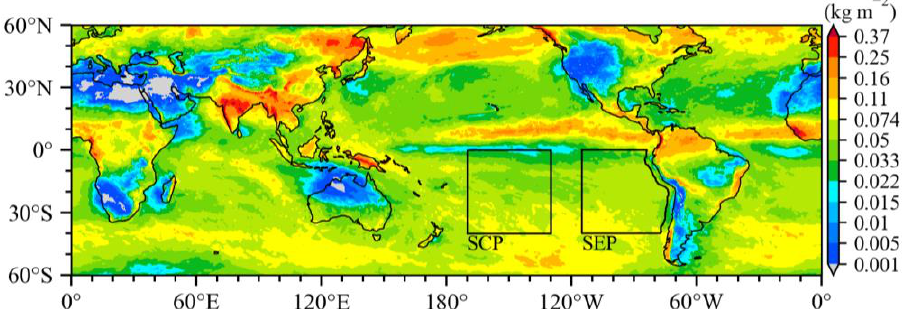
Figure 2. Monthly-mean liquid water path (LWP) in August 2020 from the ERA5 reanalysis (color shading). Also indicated are the Southeast Pacific (SEP) and the South-Central Pacific (SCP) areas, which are defined as (115°W – 70°W, 40°S – 0°) and (170°W – 130°W, 40°S – 0°), respectively.